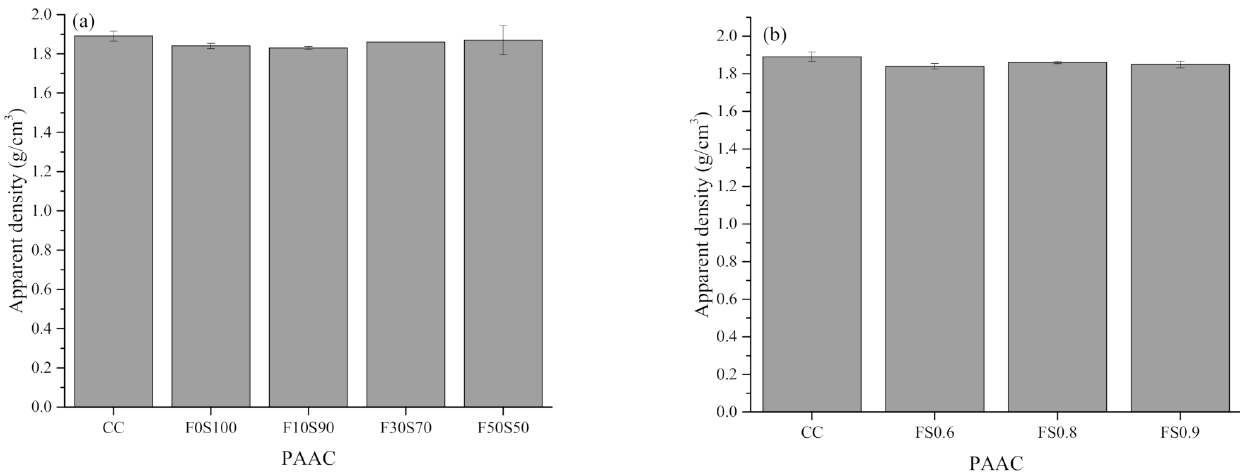
Figure 8. Apparent density of preplaced aggregate concrete mixes: ( a ) Series 1 and ( b ) series 2.